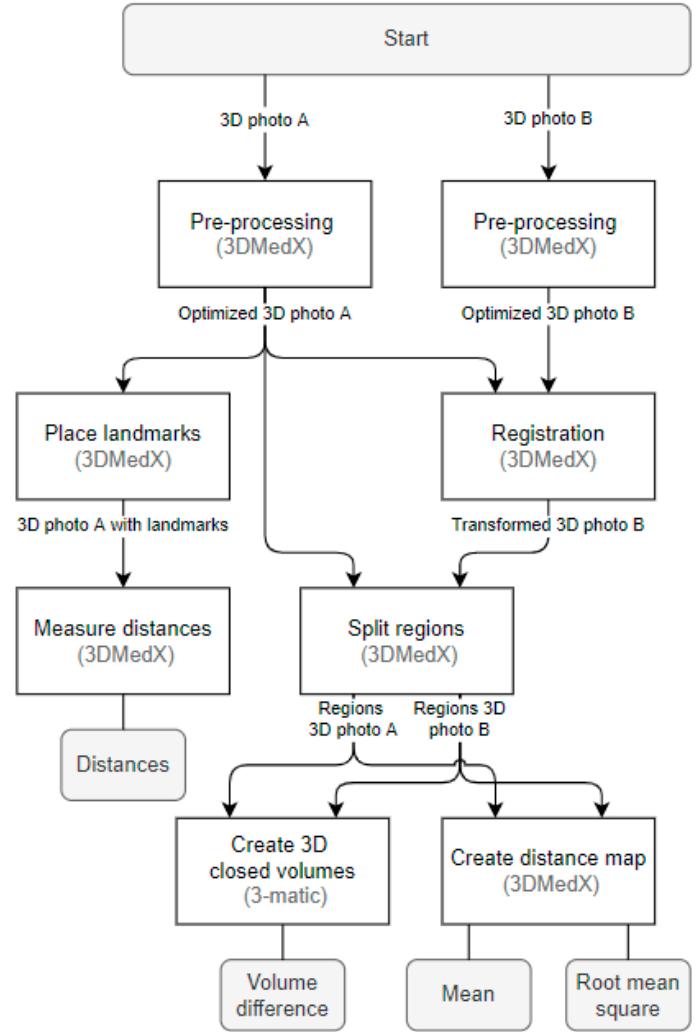
Figure 2. Flowchart for obtaining outcome parameters for 3D stereophotogrammetry. Table 1. Facial and neck landmarks with their abbreviations, explanations, and known precisions.